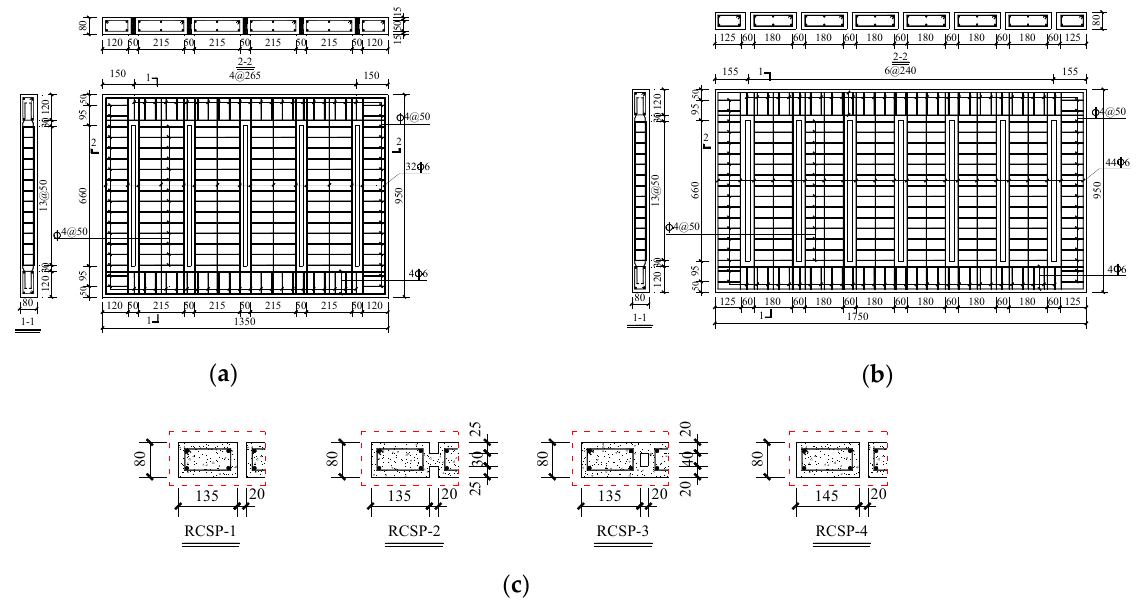
Figure 2. Steel reinforcement details of test specimens: ( a ) RCIP-1–3; ( b ) RCIP-4; ( c ) slit details (dimensions in mm).